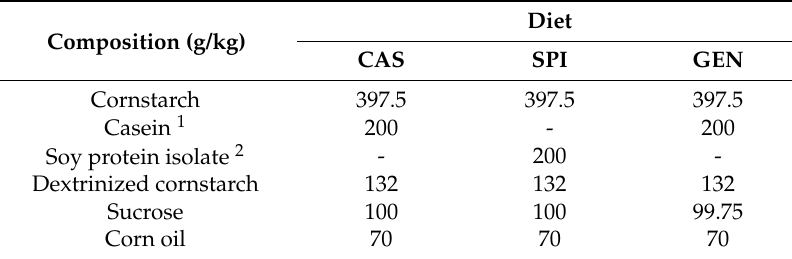
Table 1. Composition of experimental